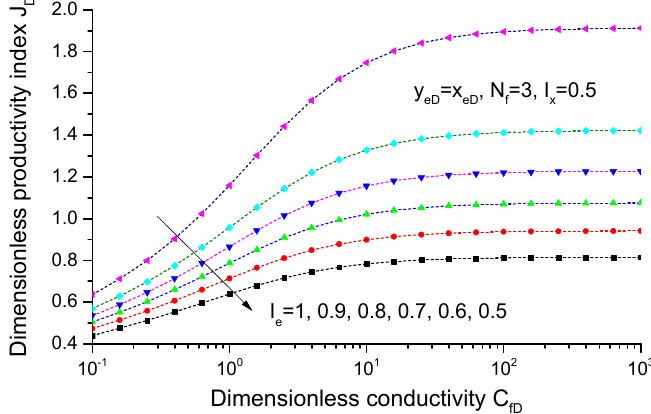
Figure 9. Influence of penetration ratio of inner SRV region with regard to the whole region on productivity-index (PI) behavior.